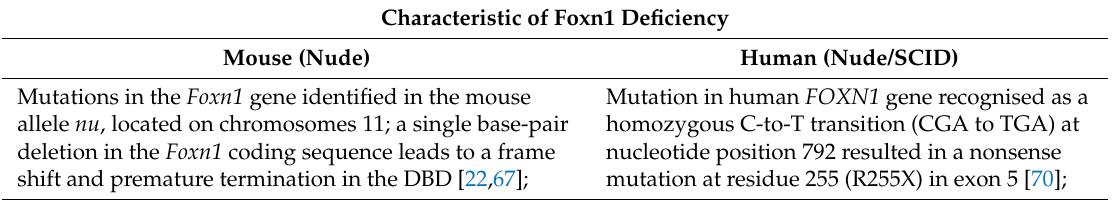
Table 1. Characterisation of Foxn1/FOXN1 mutation in mouse (nude) and human (Nude/SCID). Characteristic of Foxn1